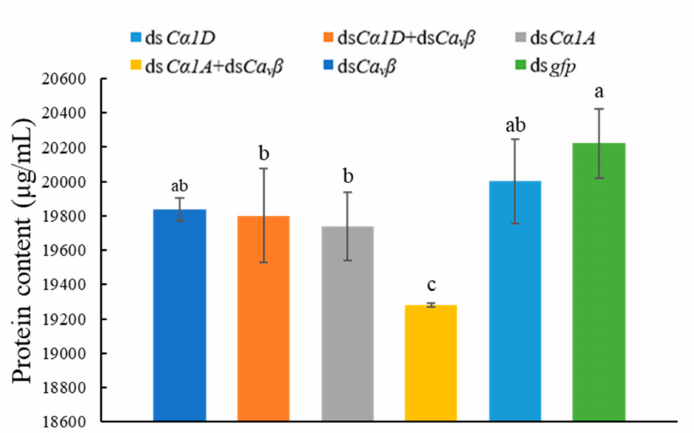
Figure 9. Silencing of Ca v β or HVA Ca v α 1 and co-silencing of Ca v β and HVA Ca v α 1 affected the protein secretion by D. destructor . Nematodes that were treated with gfp dsRNA were used as controls. Different lowercase letters indicate a significant difference at the level of p < 0.05, as tested by Duncan’s new complex difference